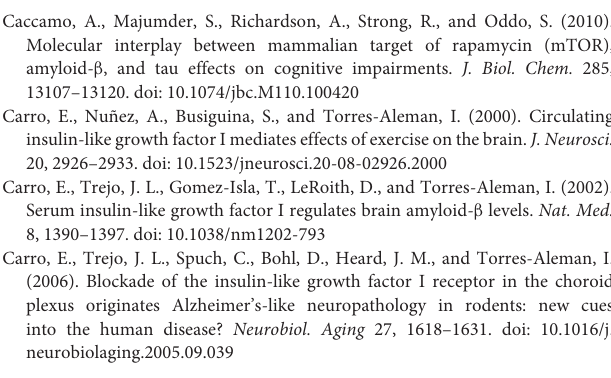
FIGURE S1 | Administration of PPP downregulated p-IGF-1R and p-tyrosine protein levels in A β PP/PS1 mice. Hippocampi from vehicle-treated wild type and A β PP/PS1, as well as PPP, treated A β PP/PS1 mice were collected 15 min following vehicle (DMSO) or 1 mg/kg PPP ip injection. Western blots were performed to investigate changes in protein levels including IGF-1R, p-IGF-1R, and p-tyrosine. GAPDH was used as the loading control. FIGURE S2 | PPP treatment did not affect the levels of cytokines in mouse temporal cortices. ELISAs were performed to quantify levels of cytokines in temporal cortex lysates from WT and A β PP/PS1 mice that were vehicle or PPP (1 mg/kg, 7 days) treated. Data are mean values normalized to tissue wet weight ± SEM ( n = 6–8 animals). Two-way ANOVA indicate MCP-1 F (1,24) = 1.407 and p (interaction) = 0.2471; IGF-1 F (1,23) = 0.03572 and p (interaction) = 0.8517; IFN- γ F (1,23) = 0.6121 and p (interaction) = 0.4420; IL-2 F (1,24) = 0.9921 and p (interaction) = 0.3292; IL-4 F (1,23) = 0.2221 and p (interaction) = 0.6419; IL-12 F (1,24) = 0.4948 and p (interaction) = 0.4885; IL-17 F (1,24) = 0.5381 and p (interaction) = 0.4703. The errors from comparisons of several pairs of means in the experiment were adjusted using Tukey’s multiple comparison tests. FIGURE S3 | IGF-1R inhibitor treatment exerted no effect on cytokine levels in the spleens of A β PP/PS1 mice. ELISAs were performed to quantify levels of cytokines in spleen lysates from the vehicle or PPP (1 mg/kg, 7 days) treated WT and A β PP/PS1 mice. Data are mean values normalized to tissue wet weight ± SEM ( n = 5–7 animals). Two-way ANOVA indicate GM-CSF F (1,20) = 0.0006634 and p (interaction) = 0.9797; MCP-1 F (1,20) = 0.4284 and p (interaction) = 0.5202; IFN- γ F (1,20) = 0.01967 and p (interaction) = 0.8899; TNF- α F (1,20) = 0.003344 and p (interaction) = 0.9545; IL-1 α F (1,20) = 0.04753 and p (interaction) = 0.8296; IL-1 β F (1,20) = 0.1536 and p (interaction) = 0.6992; IL-2 F (1,20) = 0.3636 and p (interaction) = 0.5533; IL-4 F (1,20) = 0.004686 and p (interaction) = 0.9461; IL-6 F (1,20) = 0.01765 and p (interaction) = 0.8956;